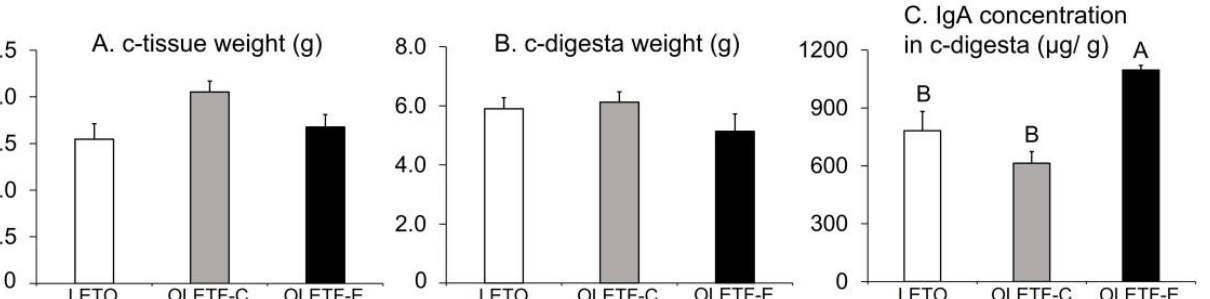
Figure 3. Hematoxylin – eosin staining of the submandibular gland (SG) tissue 16 weeks after the start of this study in the LETO ( A ), OLETF-C ( B ), and OLETF-E ( C ) groups. Magnification (400×). 3.4. c-Tissue Weight, c-Digesta Weight, and IgA Concentrations in c-Digesta The c-tissue and c-digesta weights did not significantly differ among the three groups ( p = 0.06 and p = 0.3, respectively, one-way ANOVA; Figure 4A,B). There were group differences in IgA concentrations in the c-digesta ( p = 0.001, one-way ANOVA; Figure 4C), with OLETF-E exhibiting higher values than LETO and OLETF-C ( p < 0.05, Tukey’s post- hoc test; Figure 4C). No significant difference was observed between LETO and OLETF-C (Figure 4C).